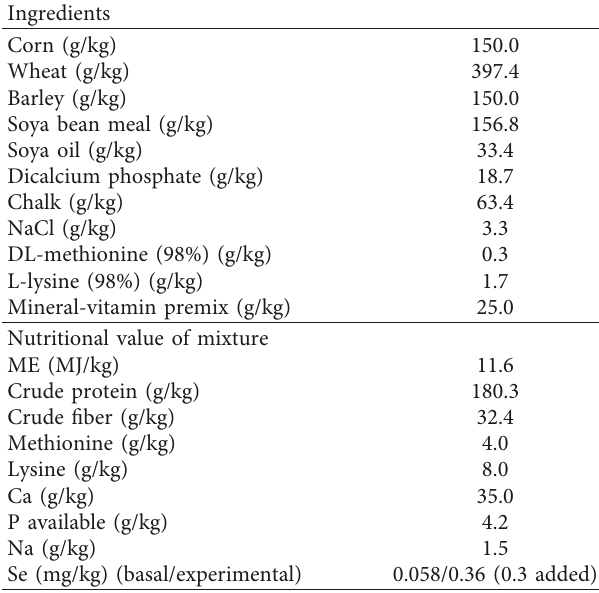
Table 1: Ingredients and nutrient levels of the basal/experimental diets.